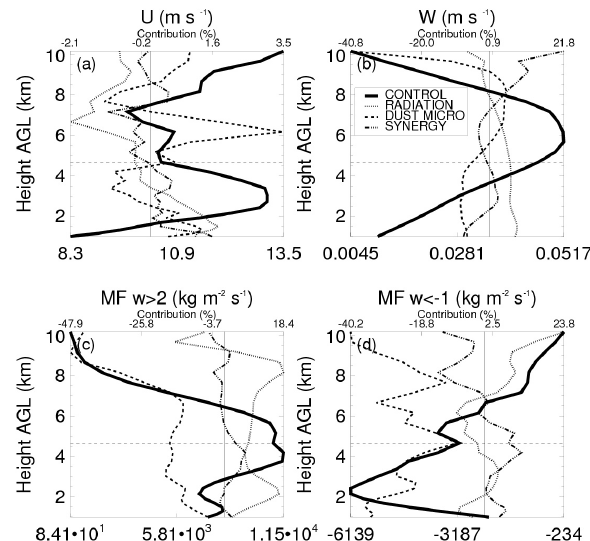
Fig. 7. Domain-averaged vertical profiles of (a) zonal wind (m s − 1 ) , (b) vertical velocity (m s − 1 ) , (c) total convective mass flux sam- pled where W > 2ms − 1 (kg m − 2 s − 1 ) , and (d) total downdraft mass flux sampled where W < − 1ms − 1 (kg m − 2 s − 1 ) . The solid lines correspond to CONTROL with the full field values on the bot- tom axes. The dotted (RADIATION), dashed (DUST MICRO), and dot-dashed (SYNERGY) lines correspond to the factors and are ex- pressed as a percent contribution to CONTROL on the top